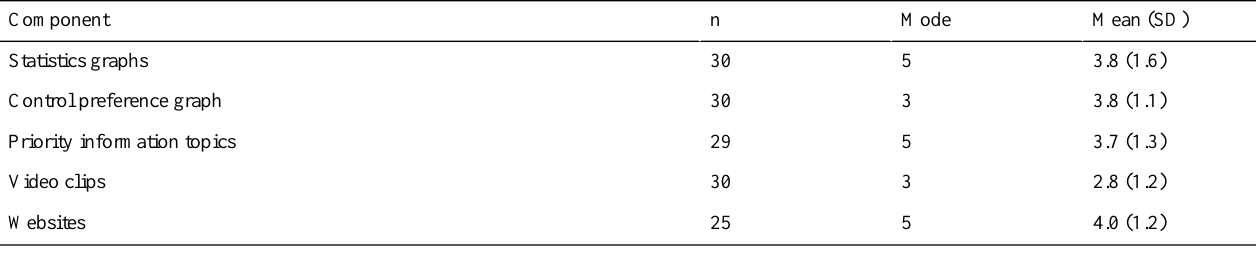
Table 6. P3P intervention component